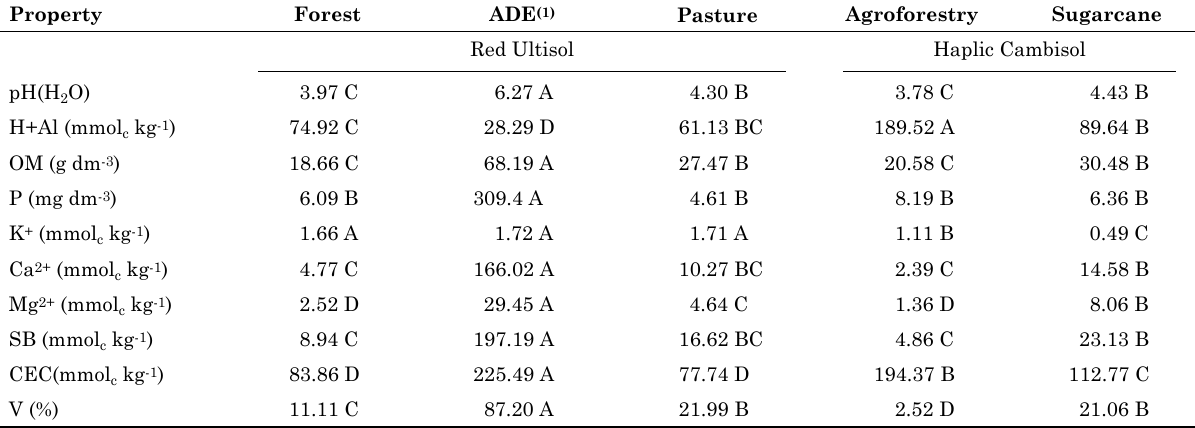
Table 1. Means test of chemical properties for the environments evaluated from the municipalities of Humaitá and Manicoré in southern Amazonas Property Forest ADE (1) Pasture